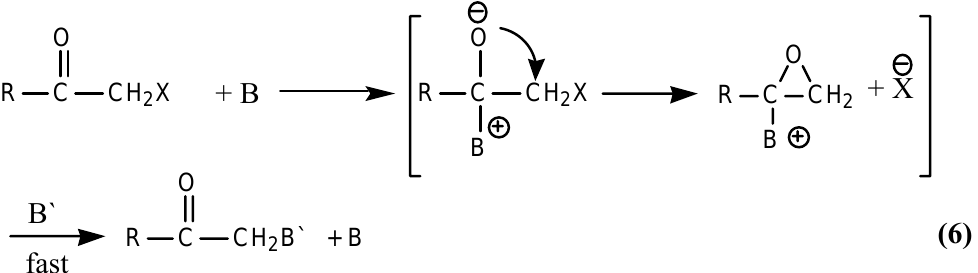
Table 5. Reactivity Relative to that of C